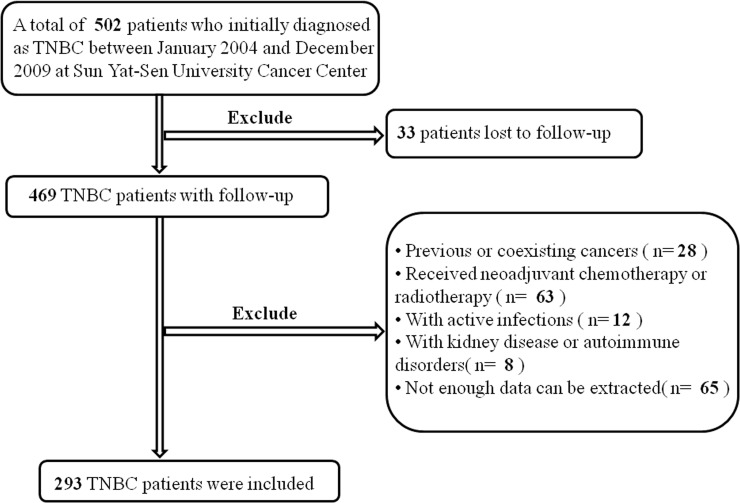
The flow chart of patient selection.